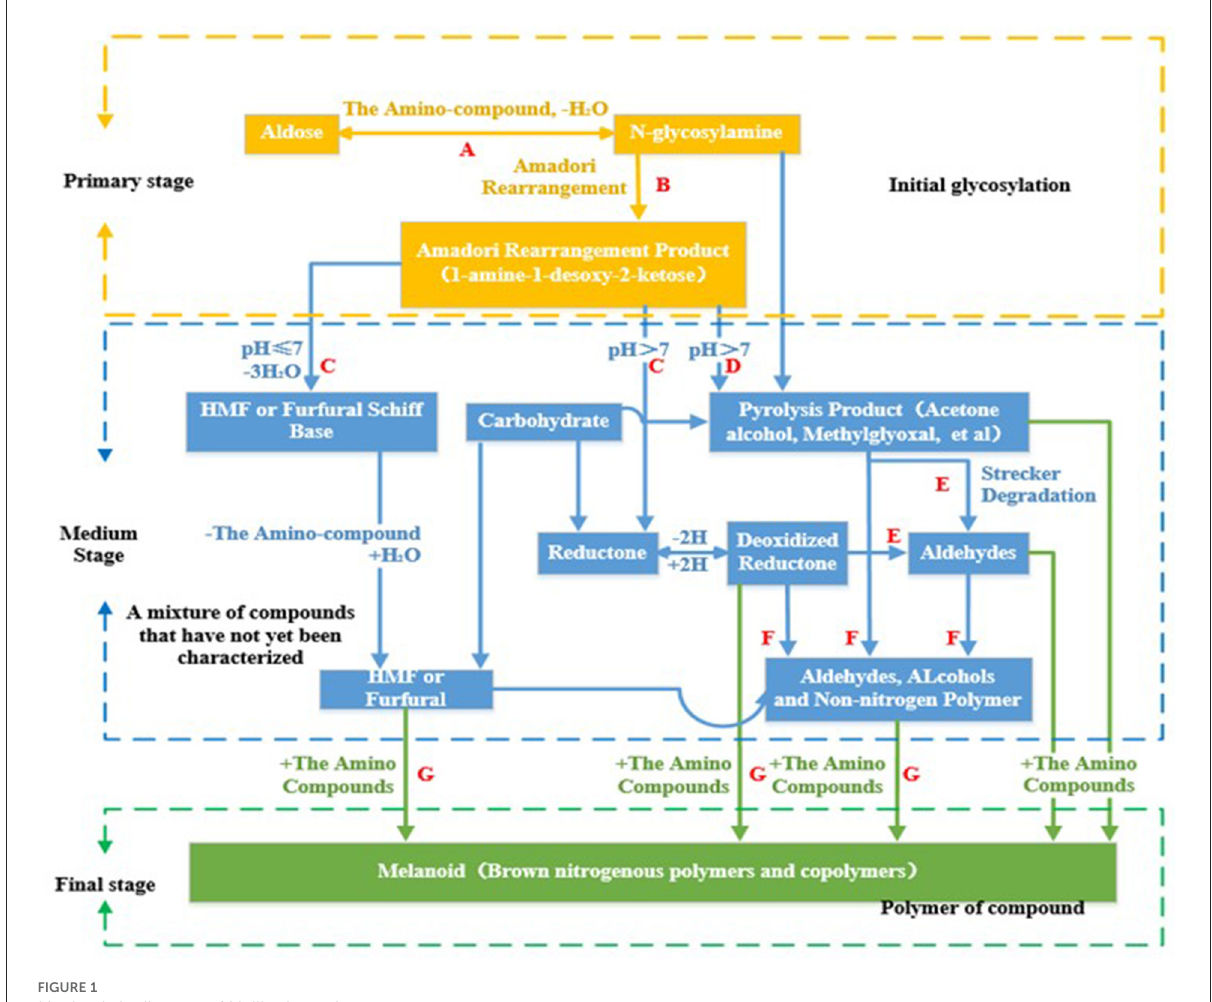
FIGURE1 Mechanistic diagram of Maillard